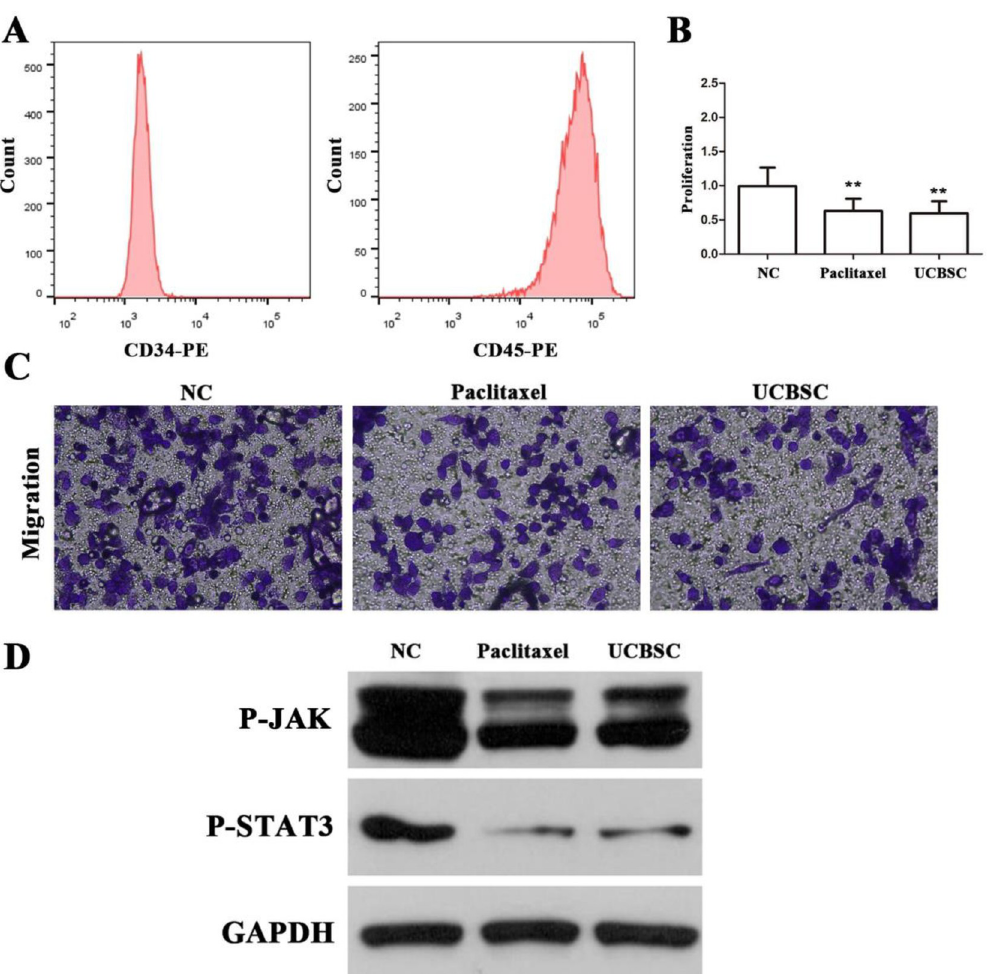
Fig 2. Inhibitory effect of HUCBSC on HA-VSMC. (A) Expression of HUCBSC cell surface markers CD34 and CD45 detected by flow cytometry. (B) The proliferation rate of each group compared by MTS cell proliferation test: The HUCBSC group and the paclitaxel group had a more significant inhibitory effect than the normal control group ( P < 0.01, respectively). �� : P < 0.01. (C) x400; The inhibition effect on HA-VSMC (cell migration experiment): The number of migrating cells in both HUCBSC group and paclitaxel group was lower than that in the control group, both groups could inhibit the migration of HA-VSMC cells, and HUCBSC group had a stronger inhibitory effect than paclitaxel group. (D) The expression of p-JAK and p-STAT3 protein in HA-VSMCs of each group: p-JAK and p-STAT3 protein expressions in HA-VSMCs were significantly decreased, both lower than those in control group ( P < 0.01).